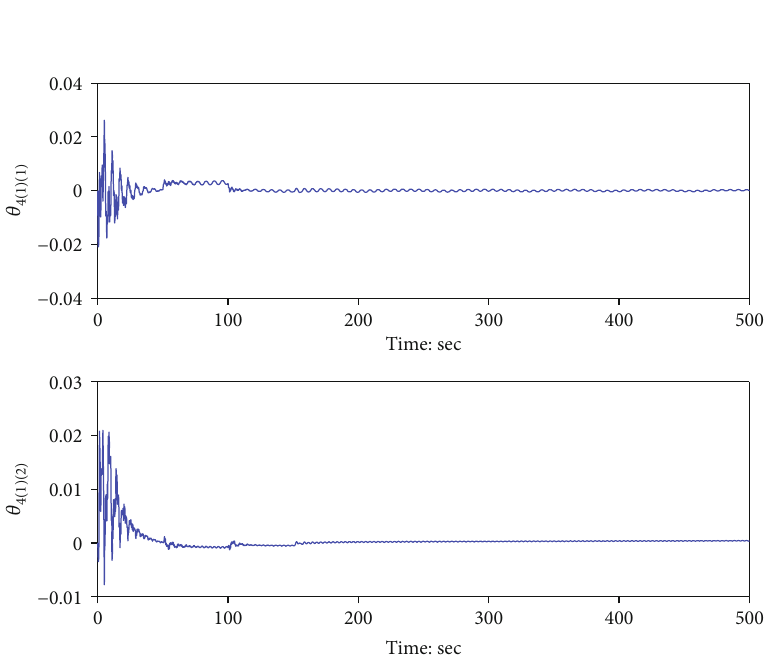
of θ ∗ . 1 ð i Þ 1 ð i Þ